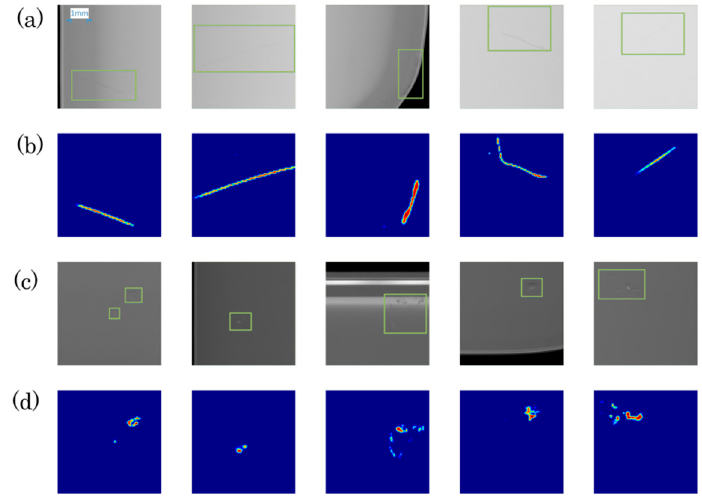
Figure 9. Segmentation results of scratch defects and dent defects: ( a , b ) are the respectively acquired defect images and segmentation results of scratch defects; ( c , d ) are the respectively acquired defect images and segmentation results of dent defects. Appl. Sci. 2020 , 10 , x FOR PEER REVIEW